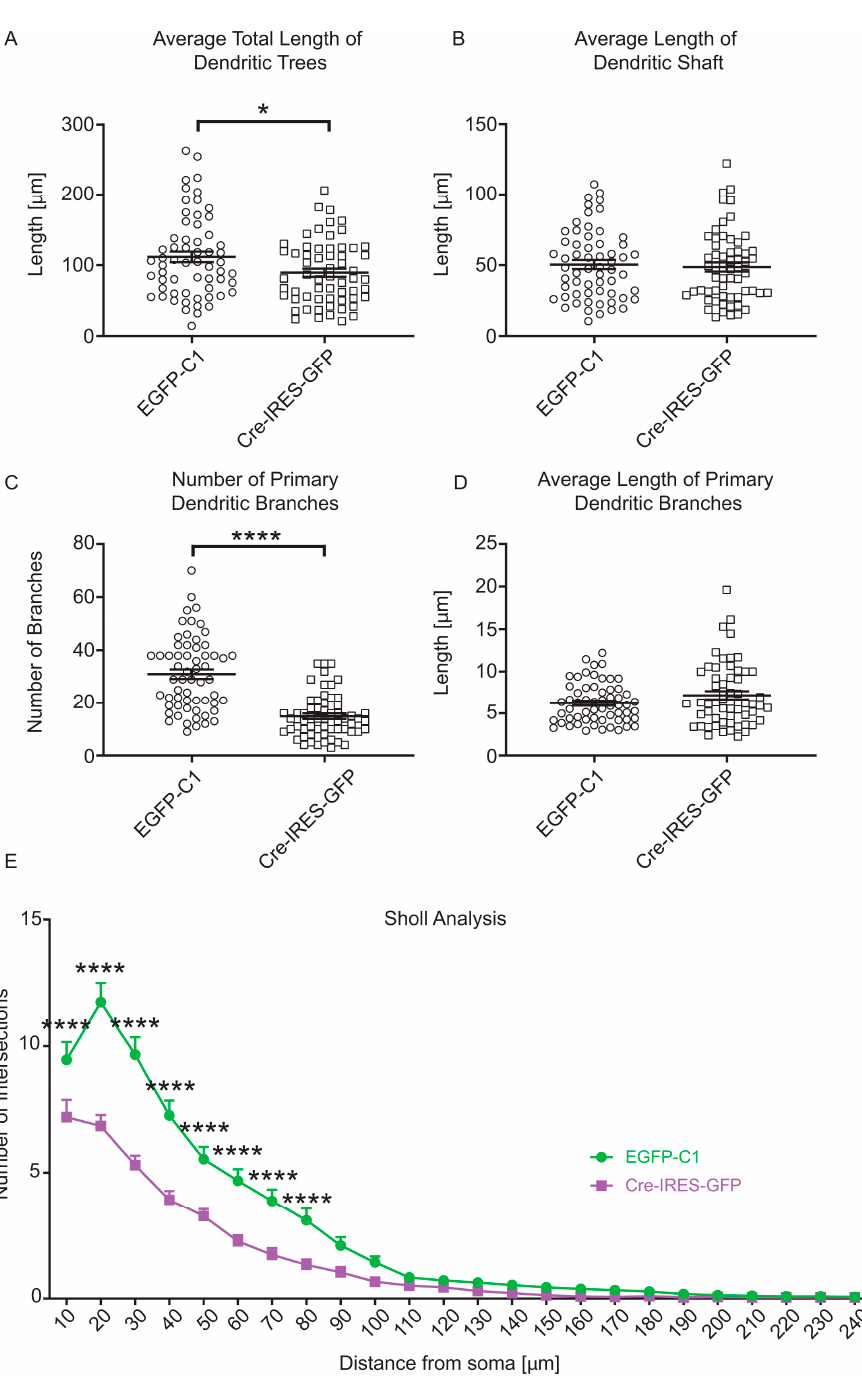
Figure 2. Quantitative analysis of dendritic morphology of Bl6 Tpm3flox neurons. Mouse primary hippocampal neurons expressed EGFP-C1 and Cre-IRES-GFP constructs for 96 h and were fixed at 4DIV. The analysed dendritic morphological parameters are: ( A ) average total length of dendritic trees, ( B ) average length of dendritic shaft, ( C ) number of primary dendritic branches, ( D ) average length of primary dendritic branches, and ( E ) Sholl analysis. In total, 55–60 neurons from three bio- logical replicates (with at least 15 neurons per replicate) were analysed for each construct. Error bars represent standard error of the mean. Significance was determined by Mann–Whitney nonparametric test: * p < 0.05, and **** p < 0.0001. Significance of Sholl analysis was determined by nonparametric two-way ANOVA test with Sidak’s test for multiple comparisons: * p < 0.05, **** p <